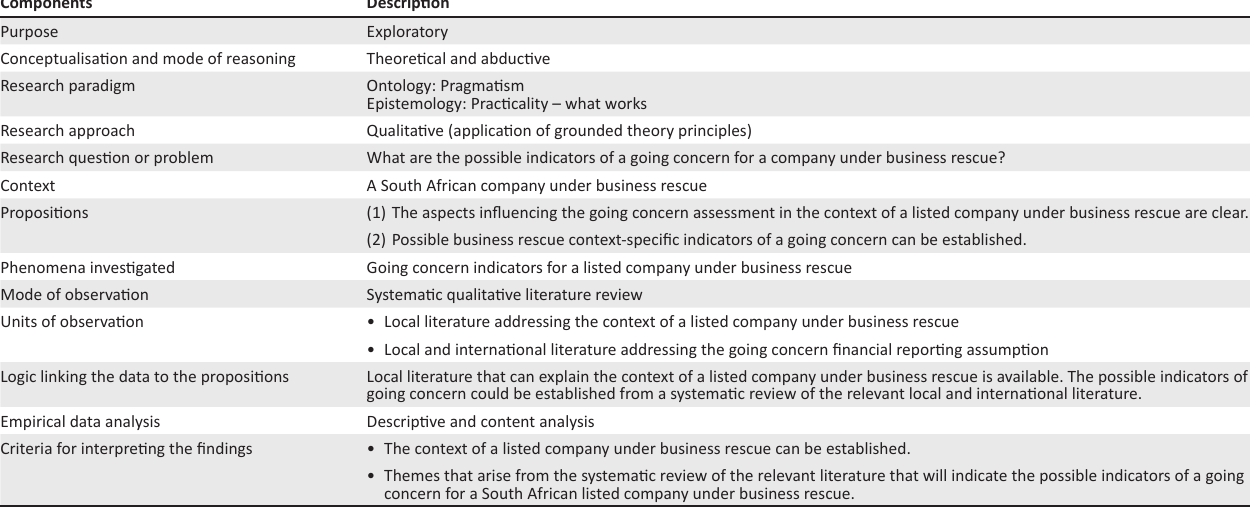
TABLE 1: Research design